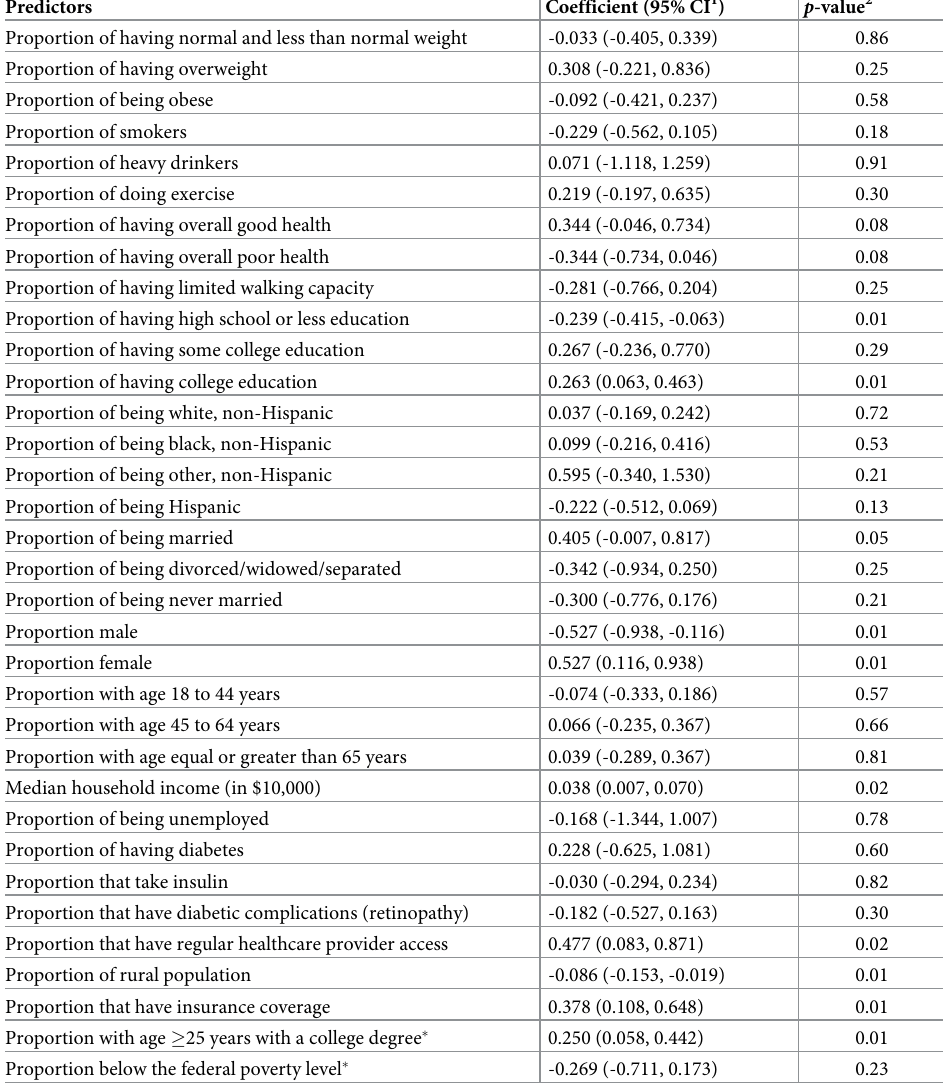
Table 5. Univariable associations between county characteristics and Diabetes Self-management Education (DSME) program participation rates in Florida,